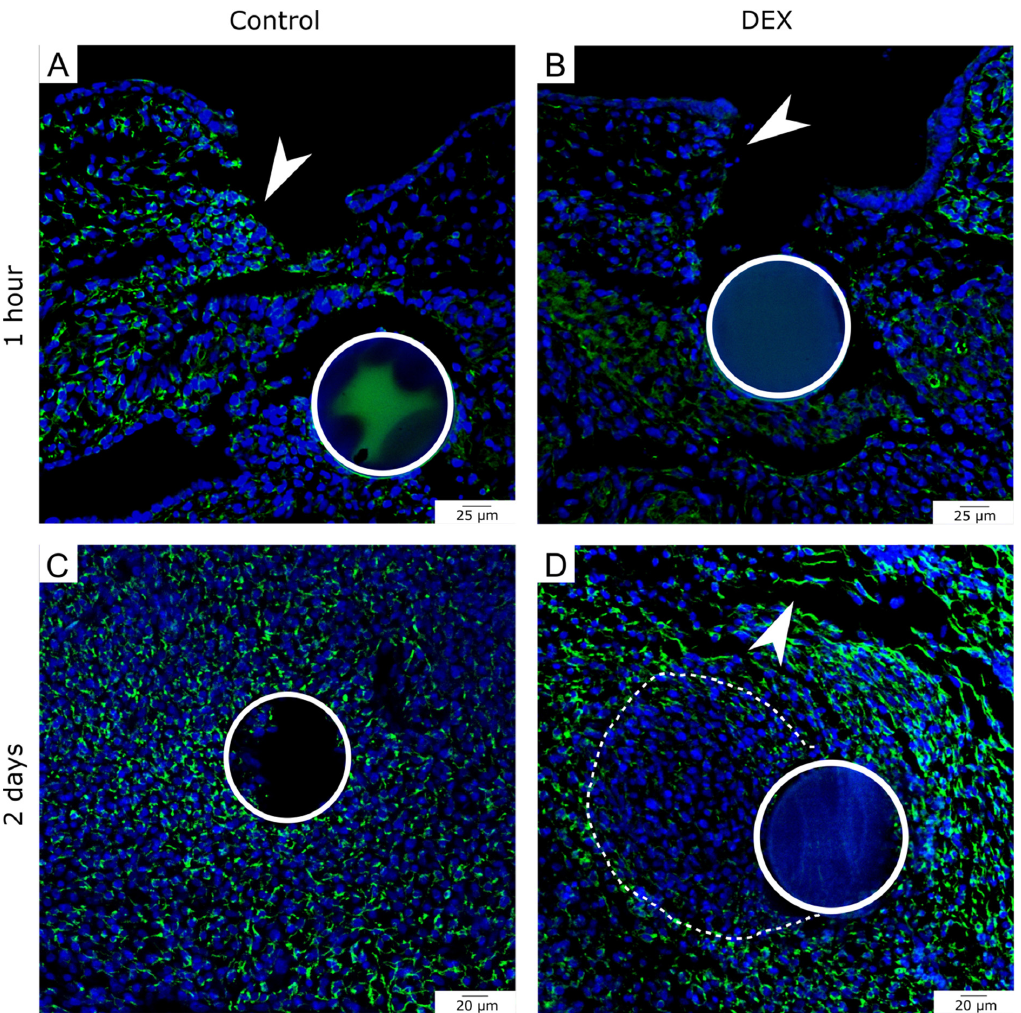
Figure 3. Vimentin expression in bead-implanted wounds. The images show immunohistochemistry for vimentin in the bead-implanted wounds. ( A ) shows a control wound after one hour. ( B ) shows a dex wound after one hour. Note the reduction of vimentin expression in the mesenchyme at the wound margin of the dex wound in comparison to the control (white arrows in ( A , B )). ( C ) shows a control wound after two days. Note, that vimentin is detected up to the bead position. ( D ) shows a dex wound after two days. Note the disturbed expression pattern of vimentin in the dex wound. There is less expression in a radius around the bead (indicated by a dotted line in ( D )), while there is strong expression around the mesenchymal defect (white arrowhead in ( D